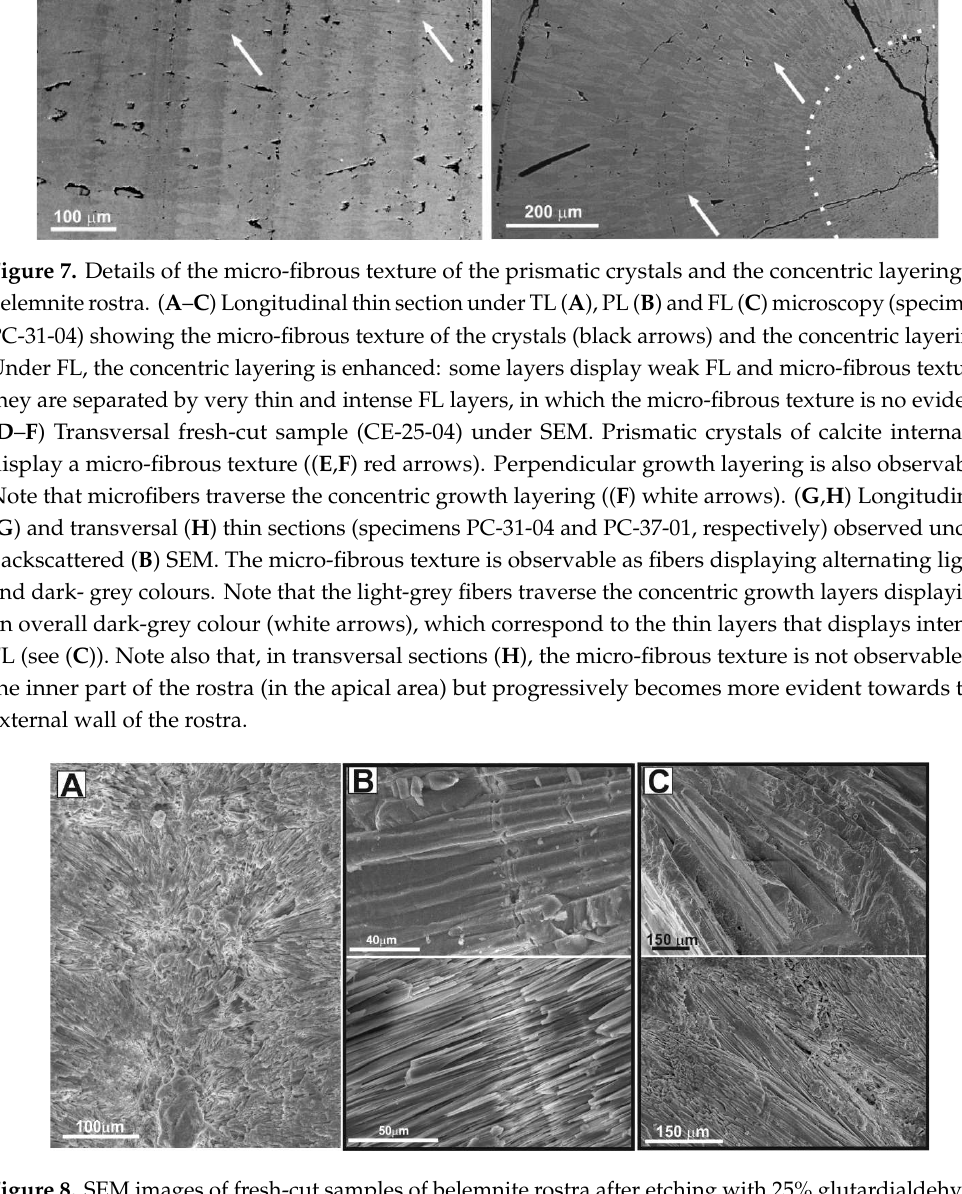
Figure 8. SEM images of fresh-cut samples of belemnite rostra after etching with 25% glutardialdehyde. Note that the micro-fibrous texture is enhanced after etching. ( A ) Equivalent image to 6B showing the spherulites developed along the apical line after etching. ( B , C ) Transversal ( B ) and longitudinal ( C ) sections of specimens PC-39 and CE-25-04, respectively, showing the prismatic habit of crystals ( up ), and the equivalent image after etching ( down ). Note that fibers traverse the concentric layers ( B ).